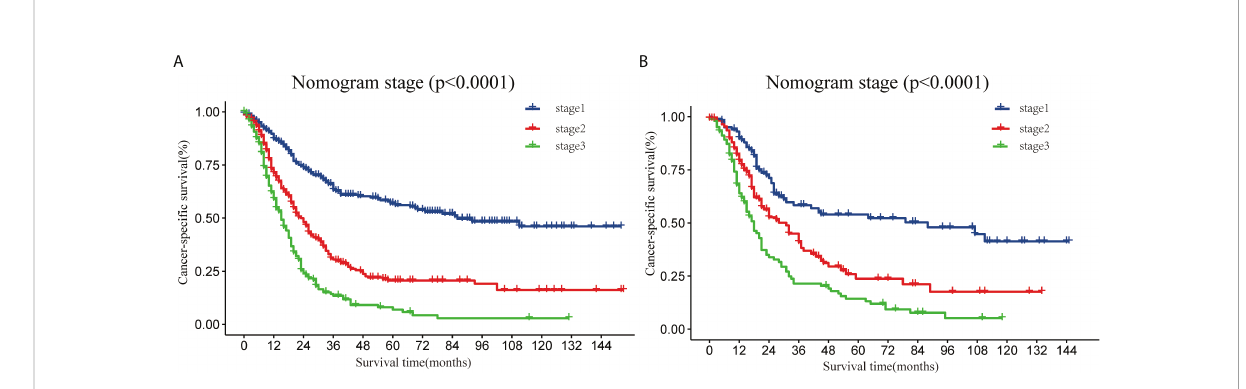
FIGURE 5 Analysis of the prognostic signi fi cance of the nomogram in surgically treated early-onset pancreatic cancer patients. Kaplan – Meier curves of CSS for all patients strati fi ed by risk scores predicted by the nomograms in training set (A) and in the validation set (B) . CSS, cancer-speci fi c